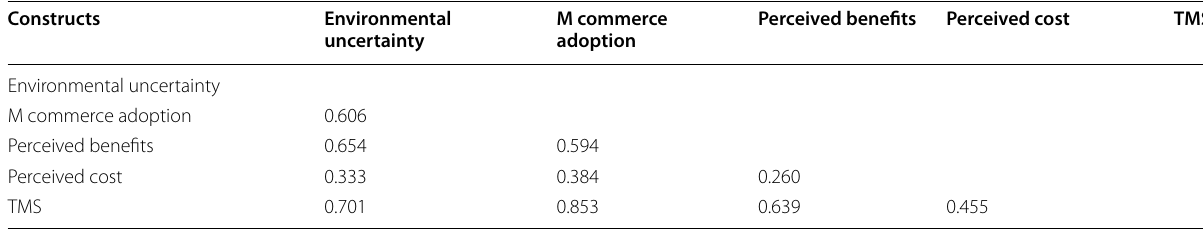
Table 5 Validity tests (Heterotrait-Monotrait Ratio